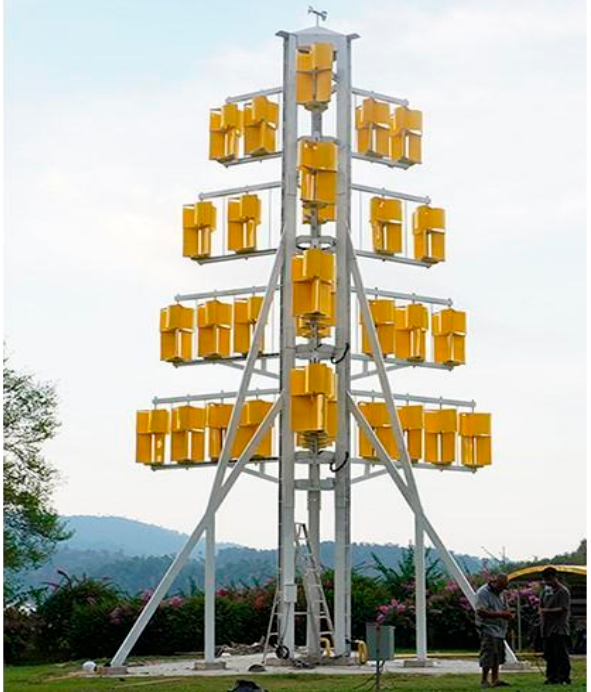
Figure 1. The prototype VAWT tree. LCAs of small-scale wind turbines have been hitherto few, with mixed results. A 600 W horizontal wind axis turbine (HAWT) assessed in Taiwan had generally unfavorable LCA results [3]. Kouloumpis et al. [12] analyzed the performance and impacts of a 5 kW